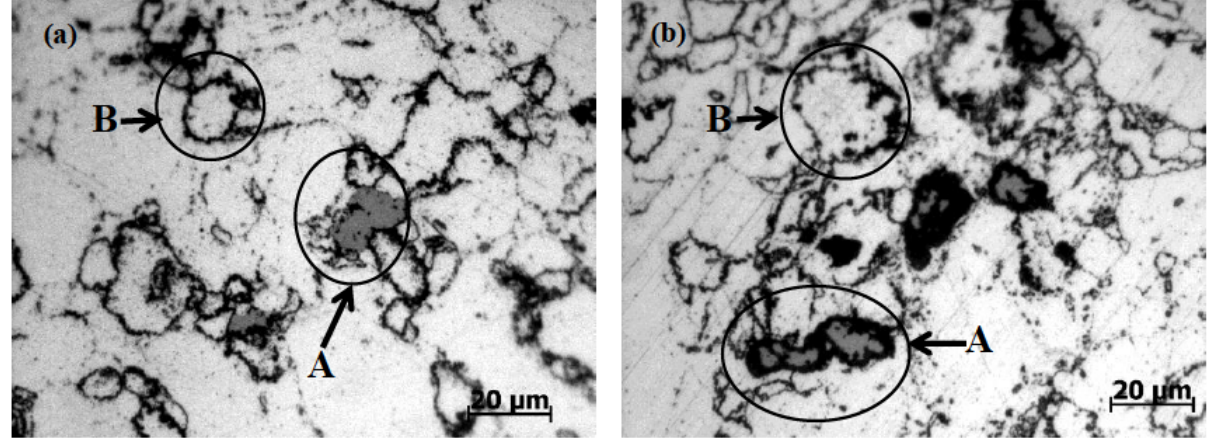
Figure 3: Microstructure of AgSnO 2 NiO ingot billet × 500; (a) biscuit; (b) sintered ingot billet;